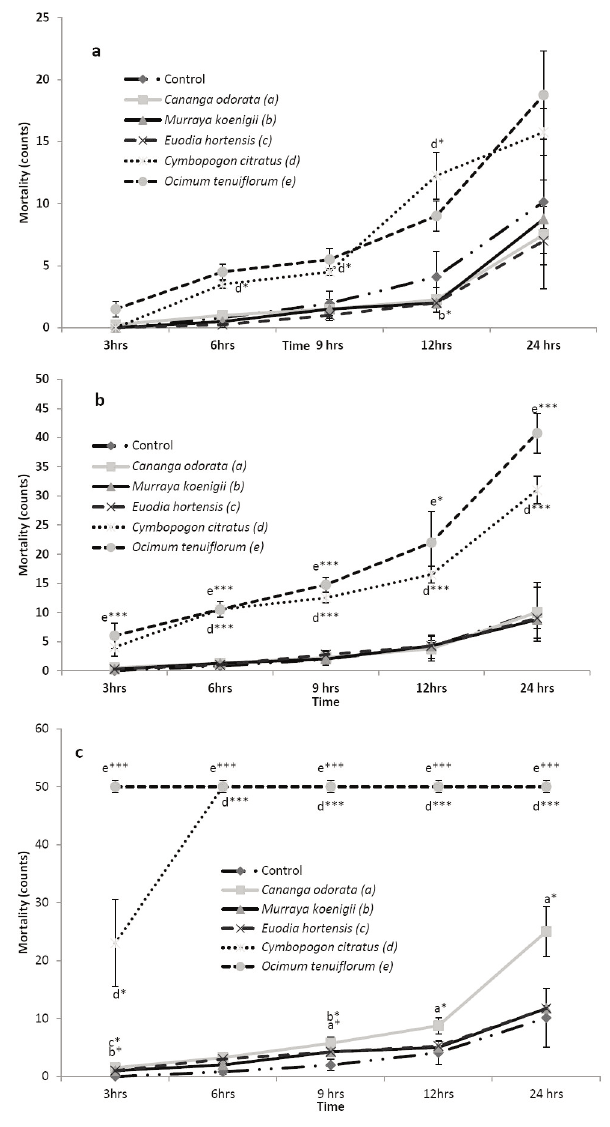
Fig. 1 - Fumigant effect (Mean±SE) of selected essential oils on the Spiralling whiteflies over different time intervals using different solution concentrations: (a) 0.25%; (b) 0.5%; (c) 5% (v/v). The alphabetical letters represent the respective essential oils and the asterisks indicate results statistically different from the control at p<0.05 (*), p<0.01 (**), p<0.001 (***) using Tukey’s